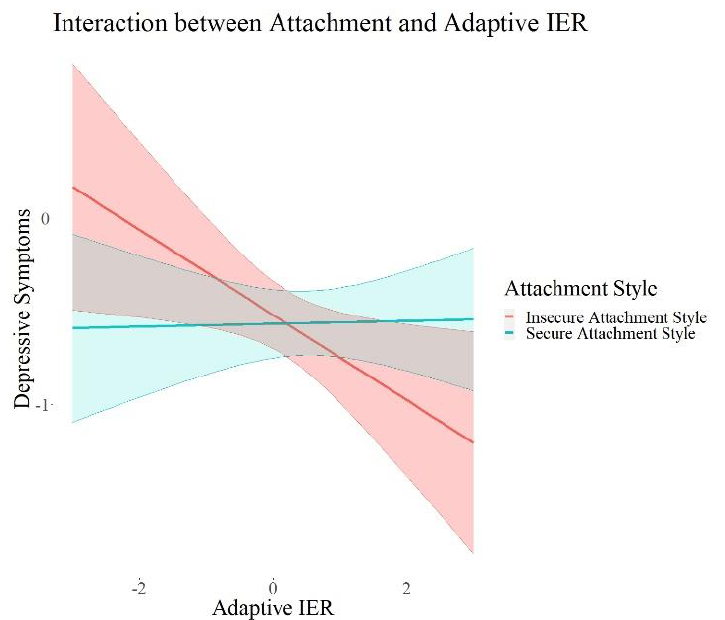
Figure 4. Interaction Effects between Attachment and Adaptive IER on Depressive Symptoms. Note . The shades behind the thicker lines represent the 95% confidence interval. All variables were standardized, and the scales on the graph represent standard deviations (i.e., 2 = 2 units of standard deviation).